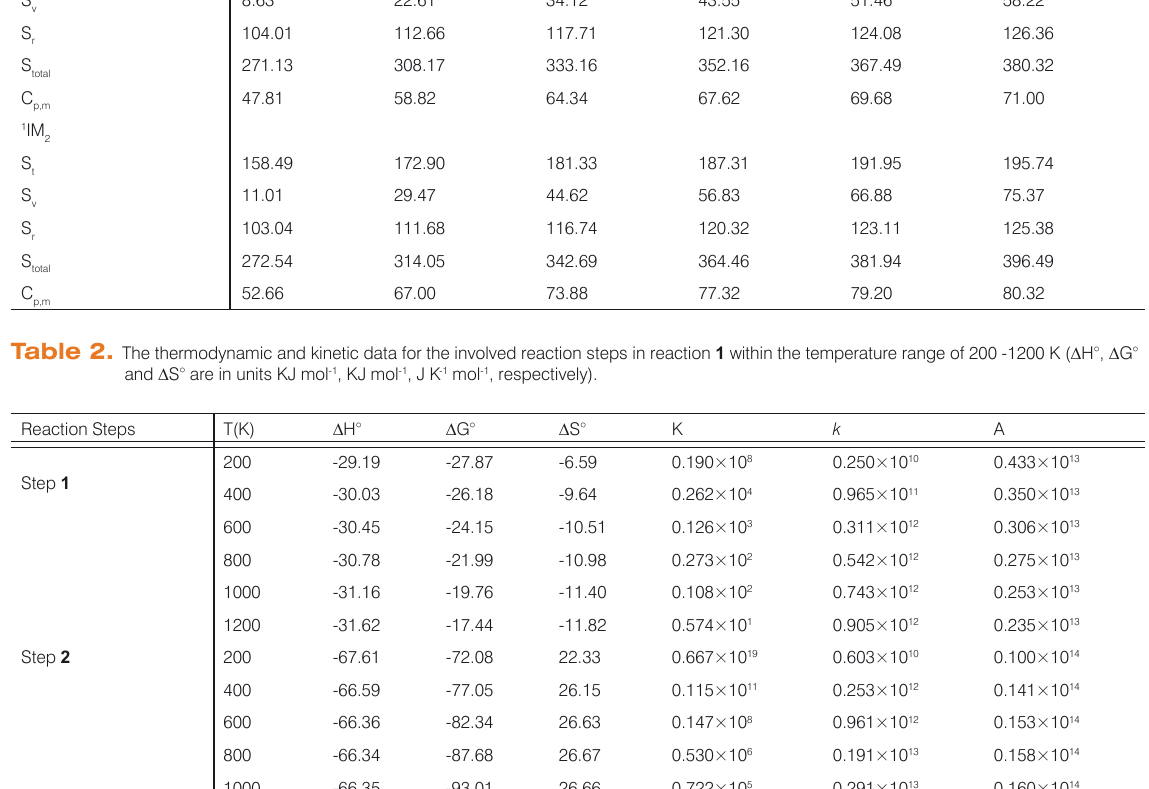
are in units p,m